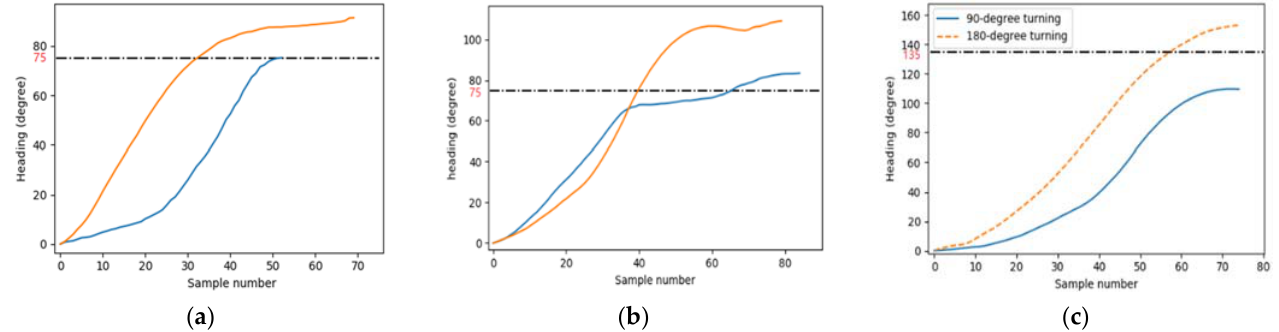
Figure 11. Examples of heading change while performing 90-degree and 180-degree turning. ( a ) Ninety-degree turning examples in C 1 , ( b ) 90-degree turning examples in C 2 , and ( c ) 90-degree and 180-degree turning in a 75-element